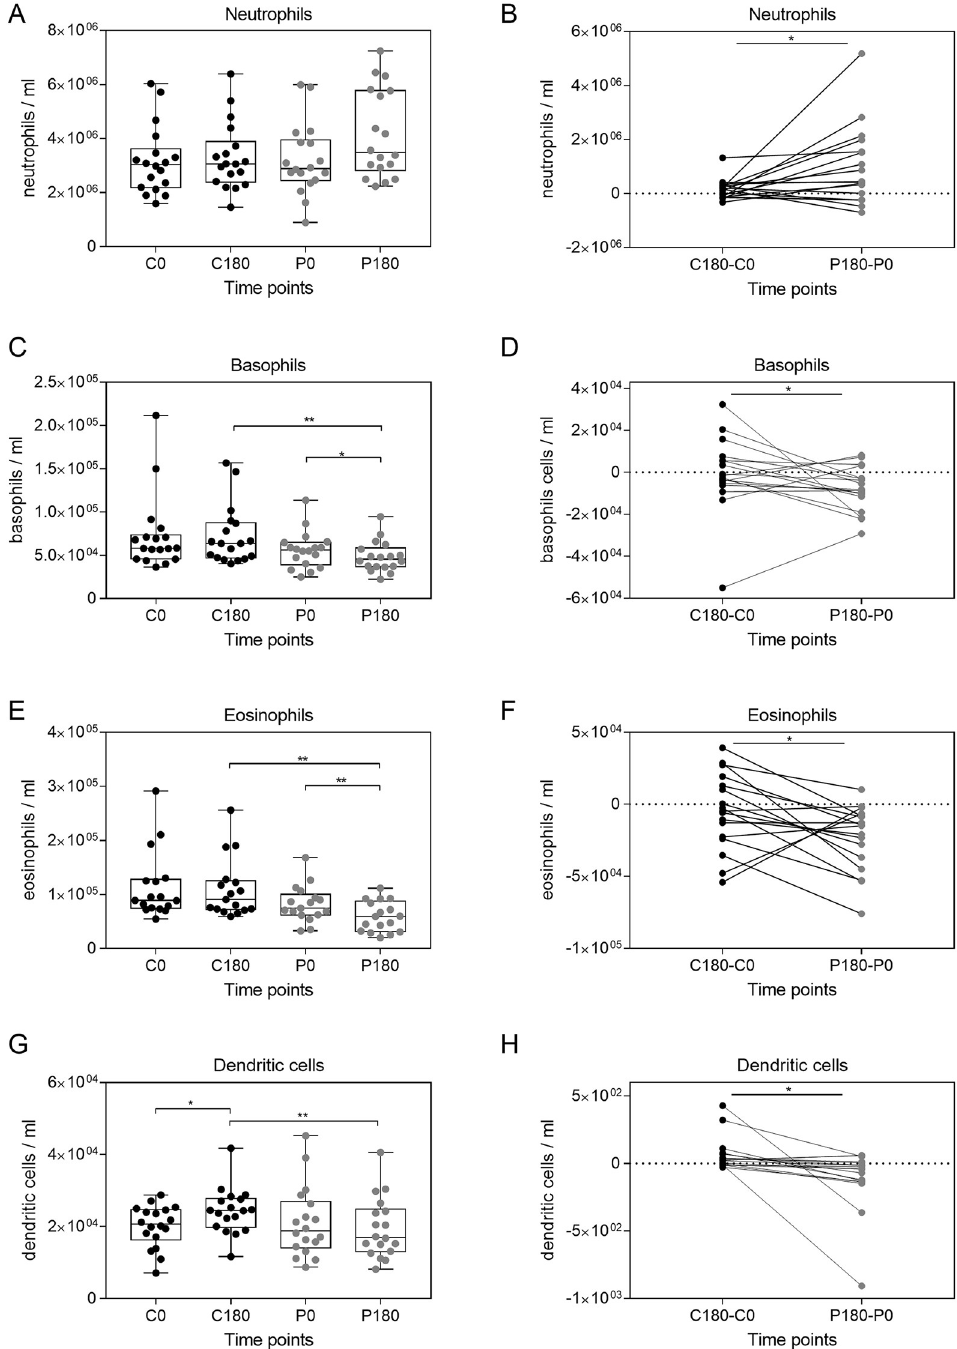
Fig 3. Major innate leukocyte populations are altered by parabolic flight maneuvers. The innate leukocyte populations were identified by flow cytometry and cell counts are shown for granulocytes (A), basophils (C), eosinophils (E), and dendritic cells (G). The differences between the control period (C180-C0) and the parabolic flight period (P180-P0) were compared for granulocytes (B), basophils (D), eosinophils (F), and dendritic cells (H). Asterisks indicate p-values ( ��� p < 0.001; �� p < 0.01; � p < 0.05) for statistical comparison. See S3 Fig for the gating strategy identifying dendritic